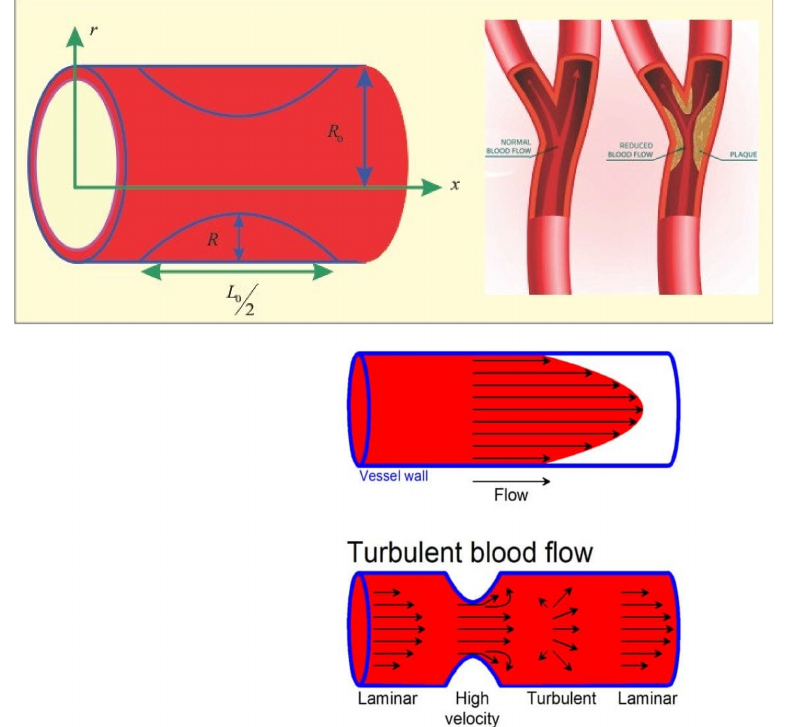
Figure 1. Geometry of the